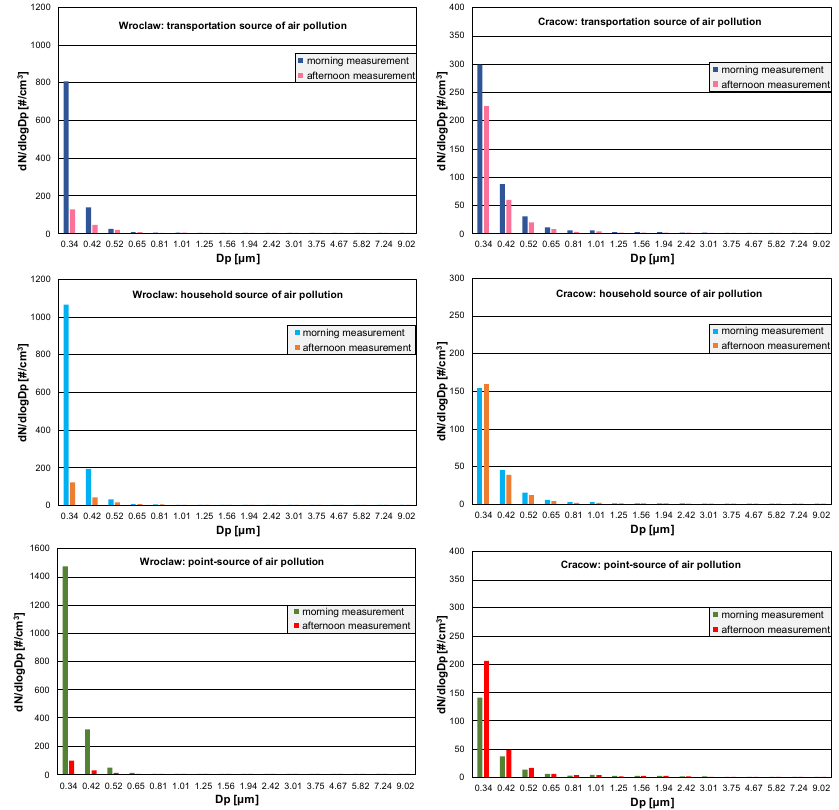
Figure 1. Particle number (PN) distributions in Wroclaw and Cracow.